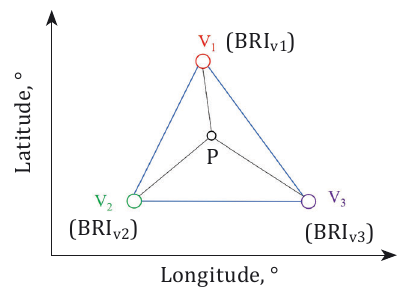
Figure 9. Triangle interpolation method for calculating BRI Longitude,